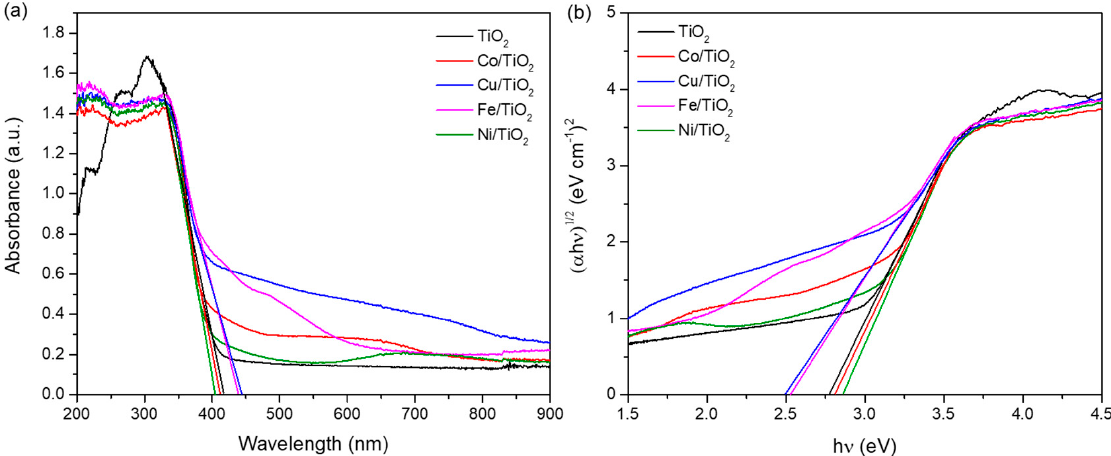
Figure 4. UV-Vis spectra and determination of the bandgap energies. ( a ) UV–vis absorption spectra of TiO 2 nanoparticles and photocatalyst. ( b ) Tauc’s plot of pure TiO 2 nanoparticles and photocatalyst. Table 1. Optical and textural properties for the TiO 2 and deposited-TiO 2 photocatalysts. Catalyst